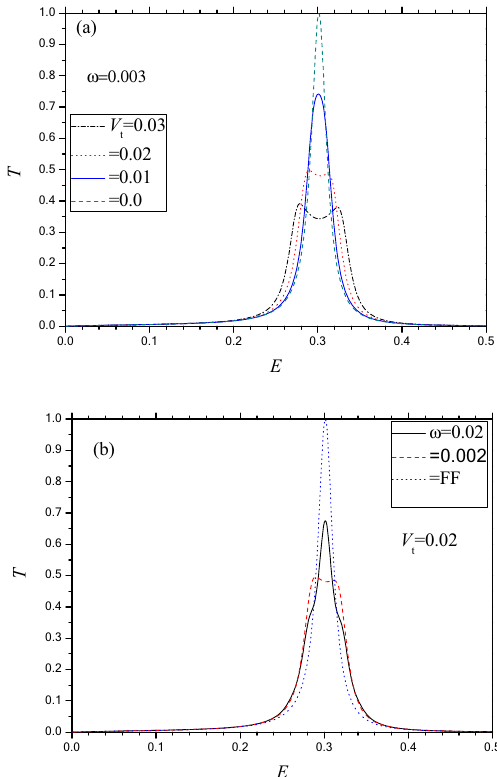
m =∞ T m = Figure 4. Total transmission T v.s. E for an oscillating (frequency in Tz region) electrostatic m =−∞ barrier (e.g. Fig. 1b) along Г–X direction under below barrier condition for k y = 0, D = 4 and V 0 = 2.5. ( a ) For (cid:29) (cid:31) (cid:30) ω = 0.03; Dash (green) line for field free (FF) case (i.e., V t = 0); Solid (blue) line for V t = 0.01; Dot (red) for V t = 0.02; Dash Dot (black) for V t = 0.03. ( b ) Same as ( a ) but for V t = 0.02; Dot (blue) for FF; Dash (red) for ω = 0.002; Solid (black) for ω =